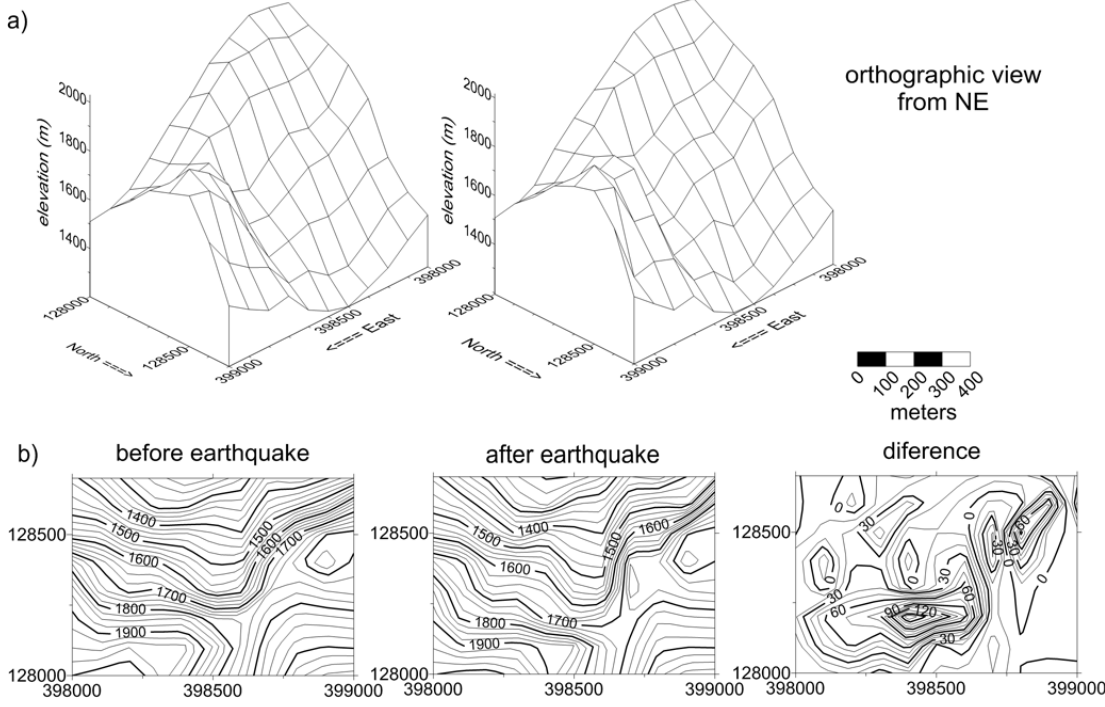
Fig. 7. Digital elevation model of V. Lemeˇz mountain showing pre- and post-earthquake topography in (a) perspective view and (b) contour maps together with the map of differences between both